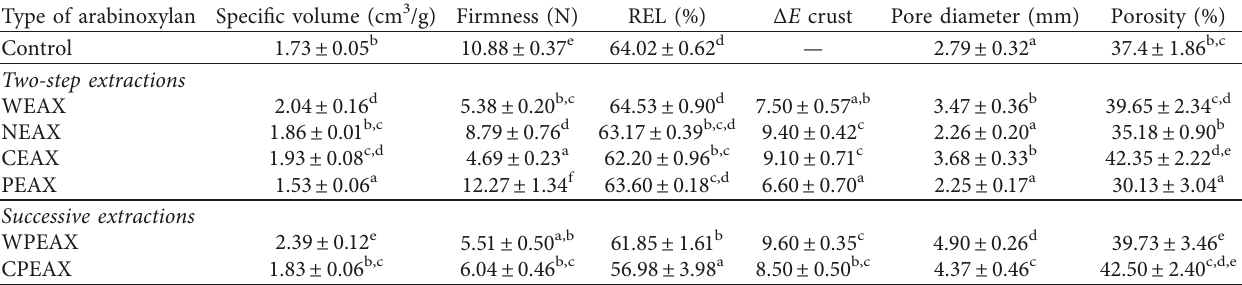
Table 3: Influence of differently extracted rye arabinoxylan on the technological properties of buckwheat sourdough-breads 1 . Type of arabinoxylan Specific volume (cm 3 /g) Firmness